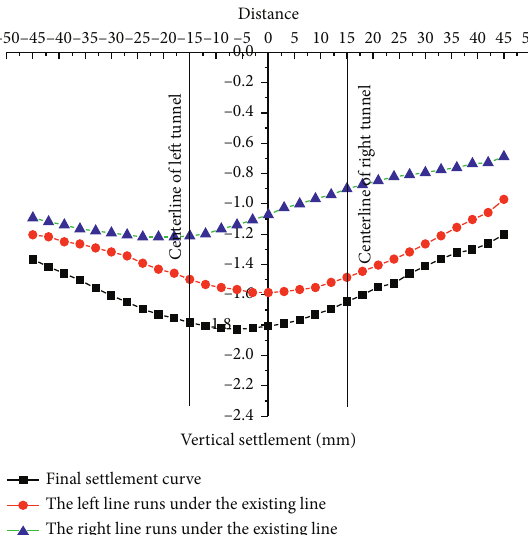
Figure 21: Settlement curve of track structure after double-tunnel